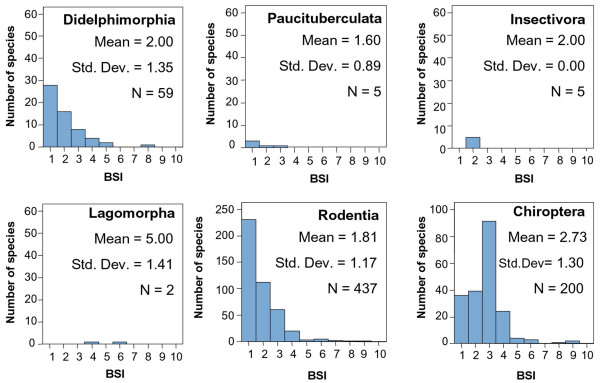
BSI histograms for micromammalian orders. Note the change in the vertical scale for Rodentia and Chiroptera. Microbiotheria is not included because it has only one species.